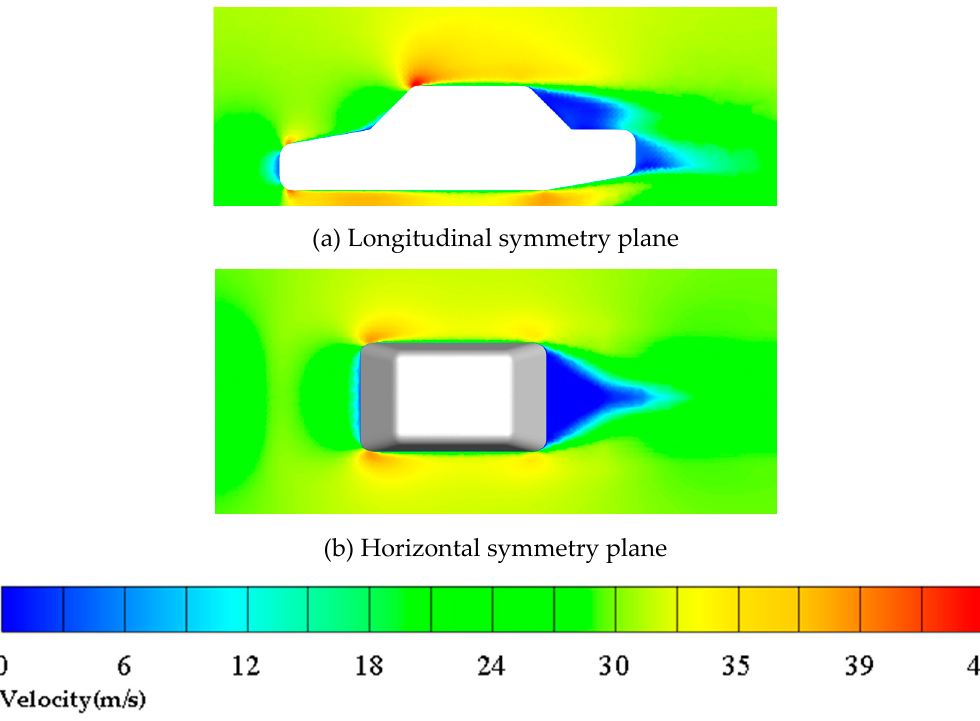
Figure 10. Velocity contour of longitudinal and horizontal symmetry plane of vehicle body.